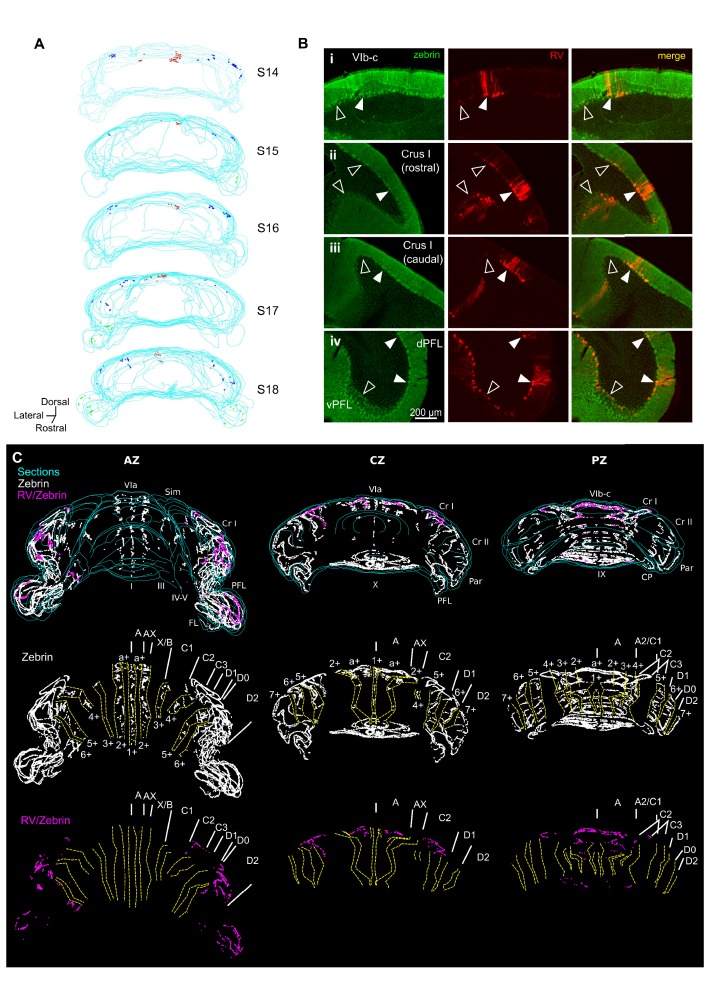
Different cerebellar modules project to the hippocampus.(A) 3-D reconstruction showing the location of RABV+ Purkinje cells in the most labeled cerebellar lobules at 66 hr post-infection. Red, blue and green dots represent RABV+ Purkinje cells in lobule VI, Crus I and paraflocculus, respectively. (B) Photomicrographs from case S18 showing double staining against zebrin II (green, left column), RABV (red, central column) and merge (right column) in lobule VI (i), Crus I (ii and iii) and paraflocculus (iv). RABV+ Purkinje cells were also zebrin positive and were organized in clusters of strongly labeled RABV+ cells (filled arrow-heads) surrounded by weakly labeled RABV+ Purkinje cells (unfilled arrow-heads). (C) Assignment of the RABV+ clusters to specific cerebellar modules for case S18 in the anterior (AZ; left), central (CZ; central column) and posterior (PZ; right column) zones. First row shows stacked sections with zebrin-positive Purkinje cells (white dots) and RABV+ Purkinje cells, which were also zebrin positive (purple dots, strong and weakly labeled cells included); central row shows reconstructed principal zebrin bands (delineated by yellow dashed lines and named from 1+ to 7+; nomenclature from Sugihara and Quy, 2007) and cerebellar modules (capital letters; defined as in Sugihara and Quy, 2007); and bottom row shows the location of the RABV+/zebrin Purkinje cells (purple dots) in relation to reconstructed zebrin bands and modules. Abbreviations, I, lobule I; III, lobule III; IV/V, lobule IV/V; VIa and VI b-c, lobule VIa and VI b-c, respectively; IX, lobule IX; X, lobule X; Sim, lobule simplex; Cr I, Crus I; Cr II, Crus II; Par, paramedian lobule; CP, copula, PFL, paraflocculus, FL, flocculus.; dPFC and vPFC, dorsal and ventral paraflocculus, respectively.